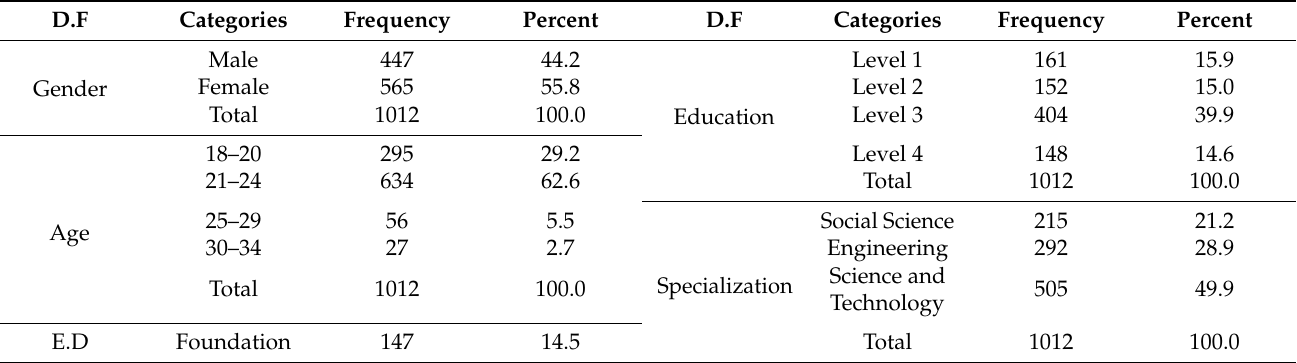
Table 1. The demographic factors analysis.